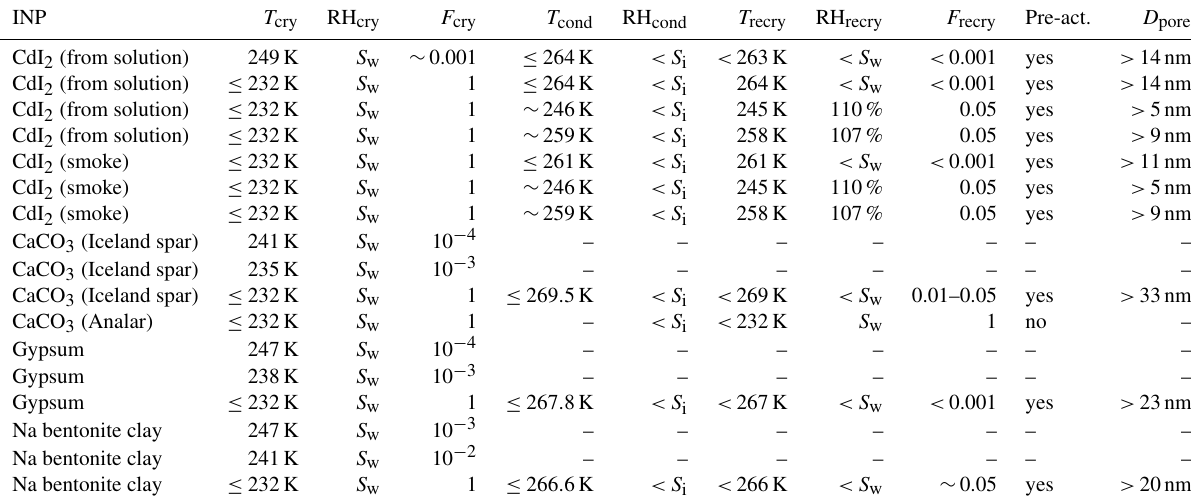
Table 2. Expansion chamber experiments by Mossop (1956). T cry – first crystallization temperature; RH cry – first crystallization RH; F cry – crystallized fraction of cloud droplets at S w or activated fraction of particles below S w ; T cond – conditioning temperature; RH cond – conditioning RH; T recry – recrystallization temperature; RH recry – recrystallization RH with respect to ice; F recry – recrystallized fraction of cloud droplets at S w or activated fraction of particles below S w ; D pore – pore diameter needed to prevent ice from melting; S w – water saturation; S i – ice